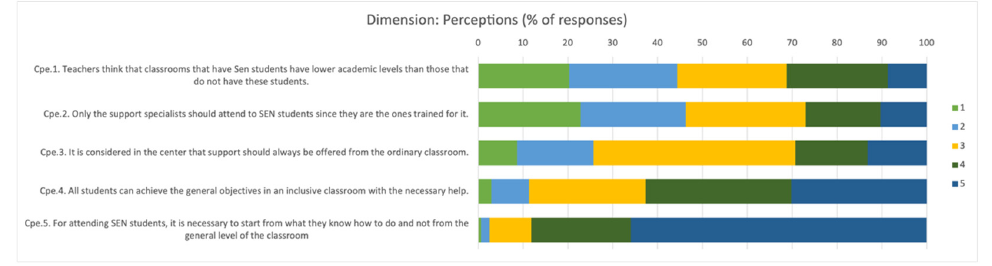
Figure 3. Percentage of responses about teachers’ perceptions of the educational response that should be offered to SEN students. 1: Strongly Disagree; 2: Disagree; 3: Undecided; 4: Agree; 5: Strongly Agree.